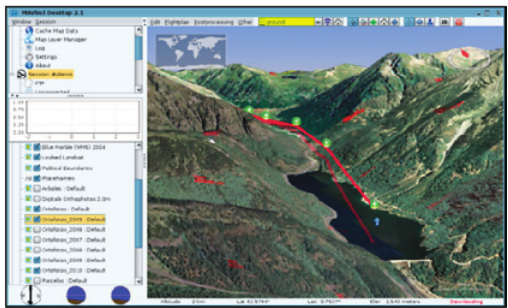
Fig. 6. Flight planning with single waypoints from MAVinci Desktop flight planning software (Images … 2011)